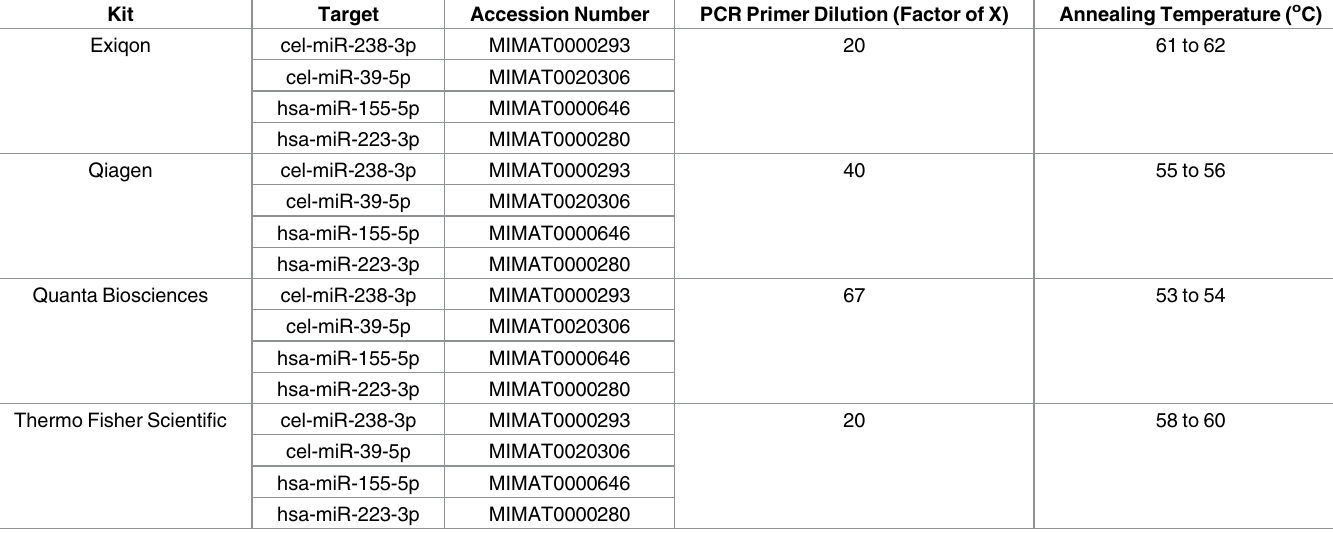
Table 3. General information about